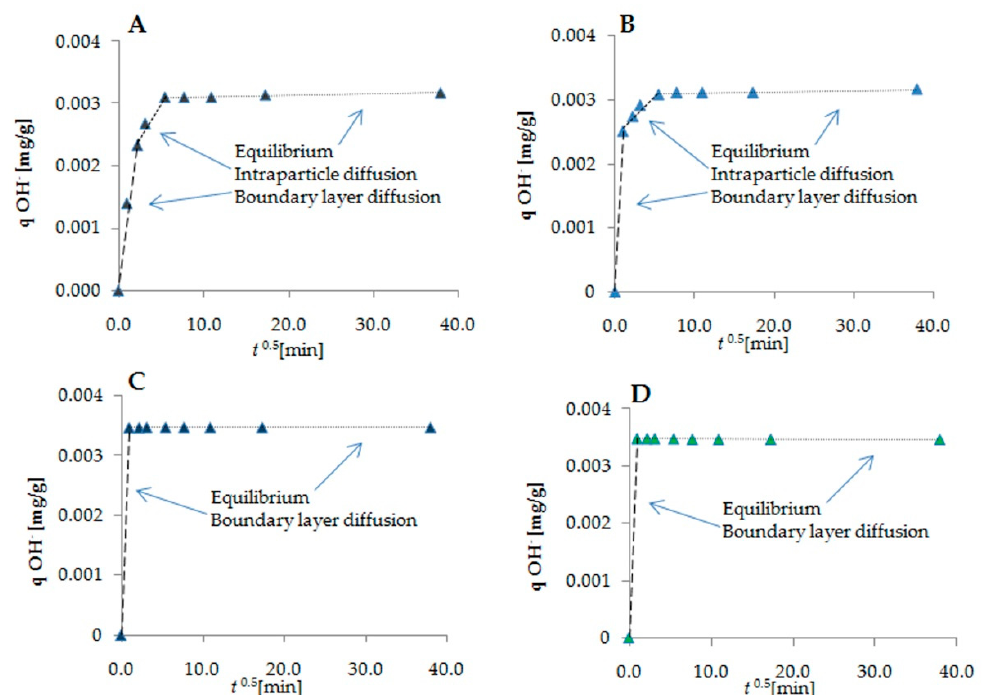
Figure 3 . Weber–Morris intraparticle diffusion model of cyclitol sorption: ( A ) D-sorbitol; ( B ) adonitol; ( C ) shikimic acid; ( D ) D-( – )-quinic acid.